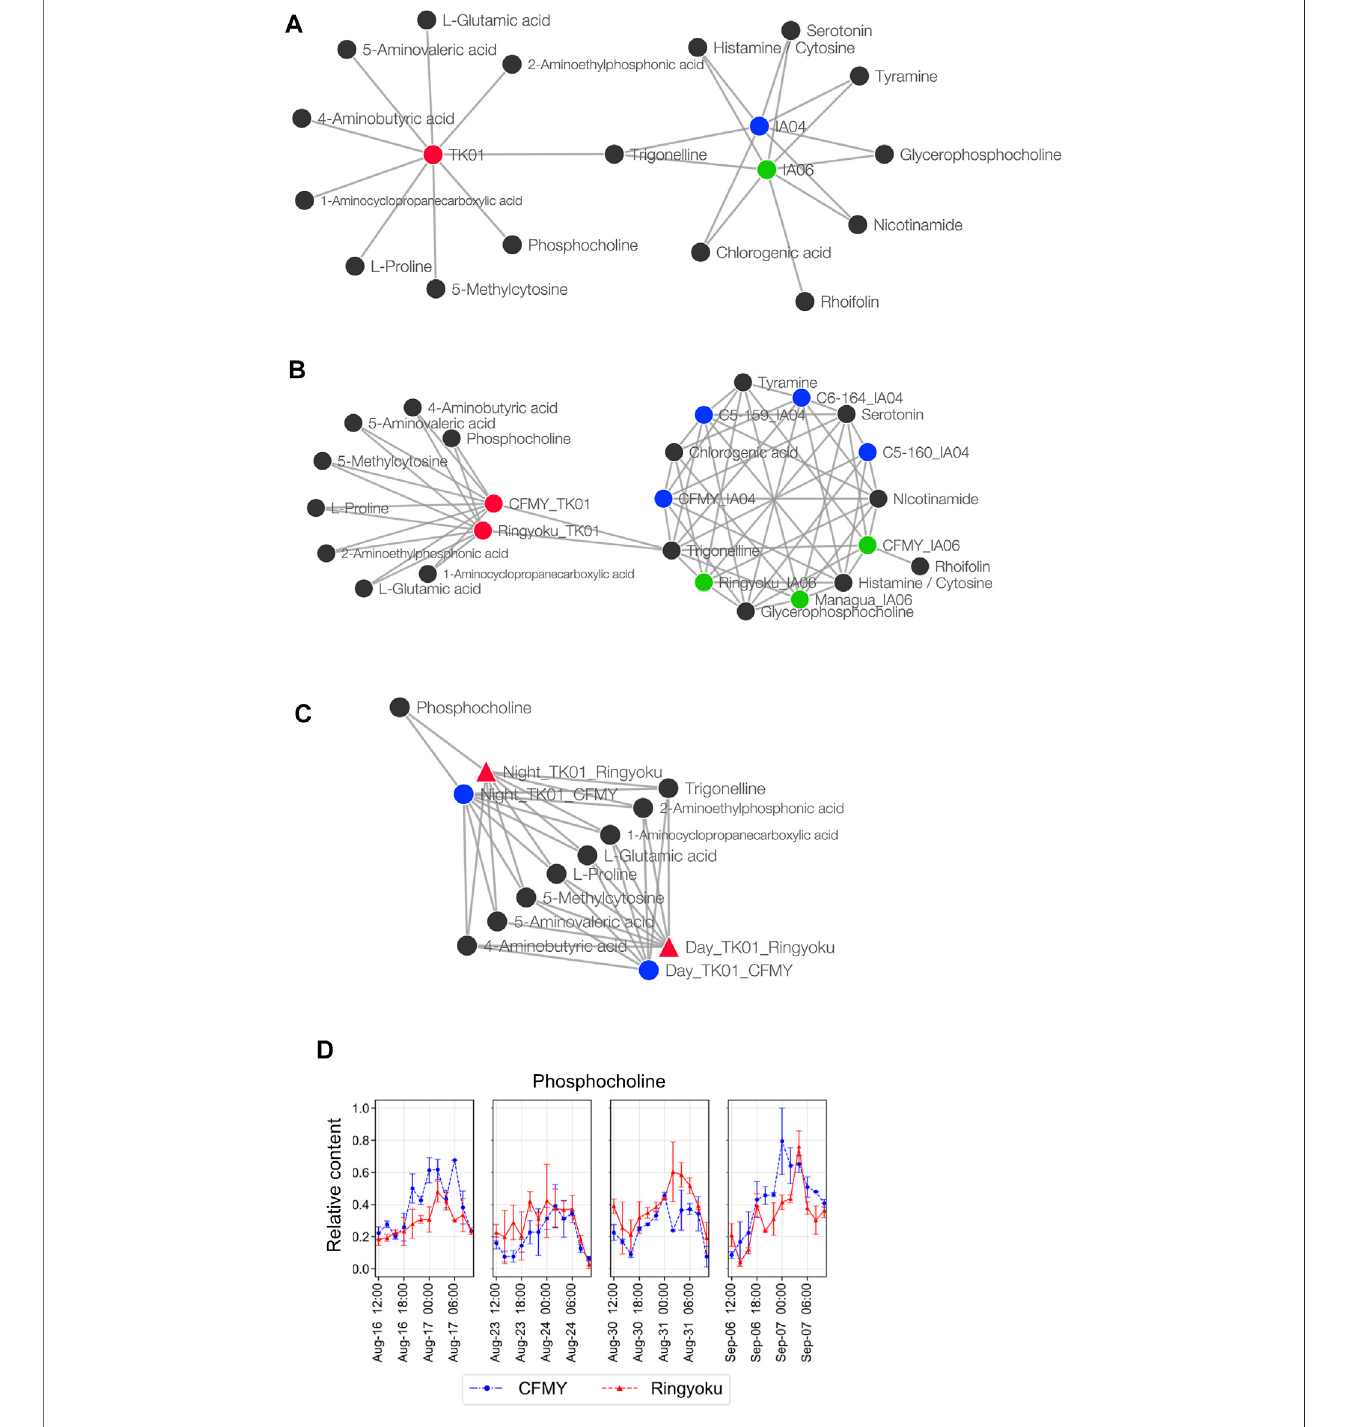
FIGURE 5 | Metabolite association with experimental designs, cultivars, and sampling times. (A) Network of metabolites and growth conditions. (B) Network of metabolites and cultivars. The cultivars were divided into subcategories of experimental design; for example, the CFMY samples were divided into three and labeled CFMY_TK01, CFMY_IA04, and CFMY_IA06. (C) Network of metabolites and sampling times. (D) Diurnal changes of the relative content of phosphocholine (scaled between 0 and 1).